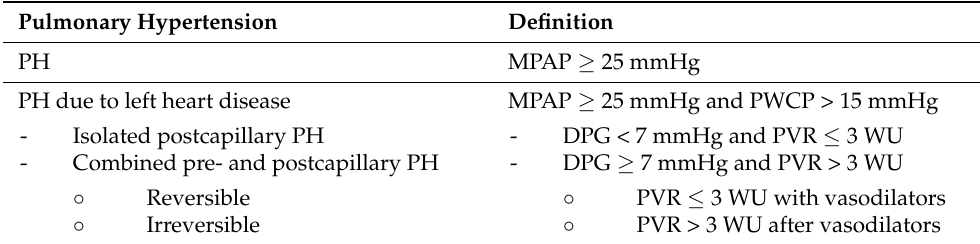
Table 2. Definition of pulmonary